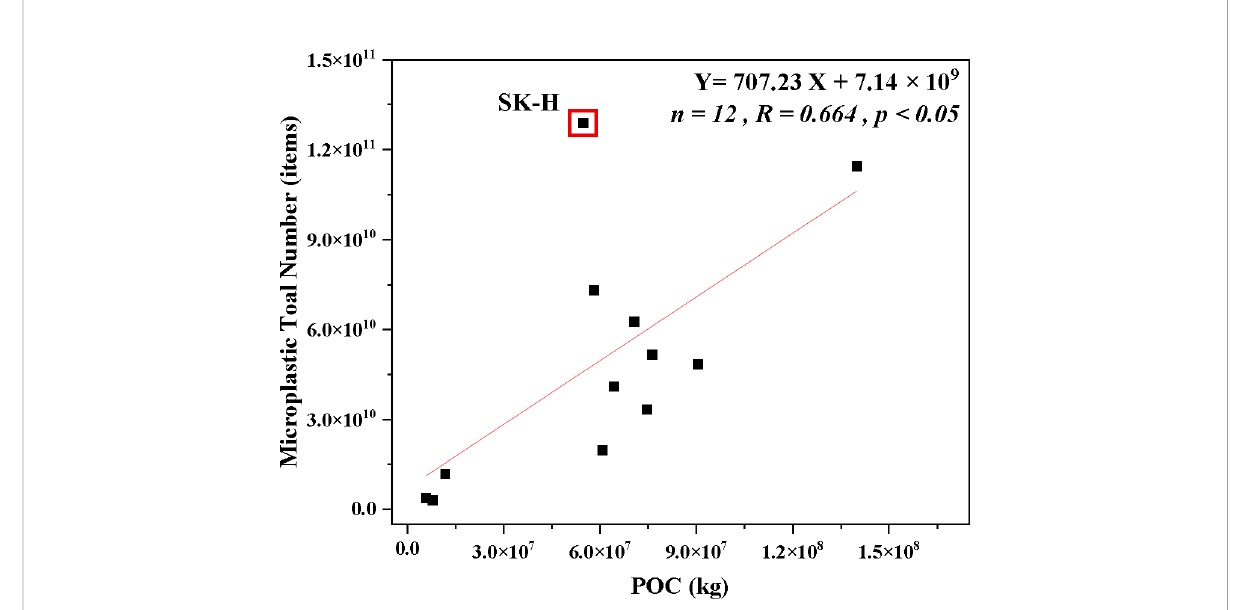
FIGURE 7 The linear regression relationship between total particulate organic carbon (POC) and microplastic (MP) total number in mangrove